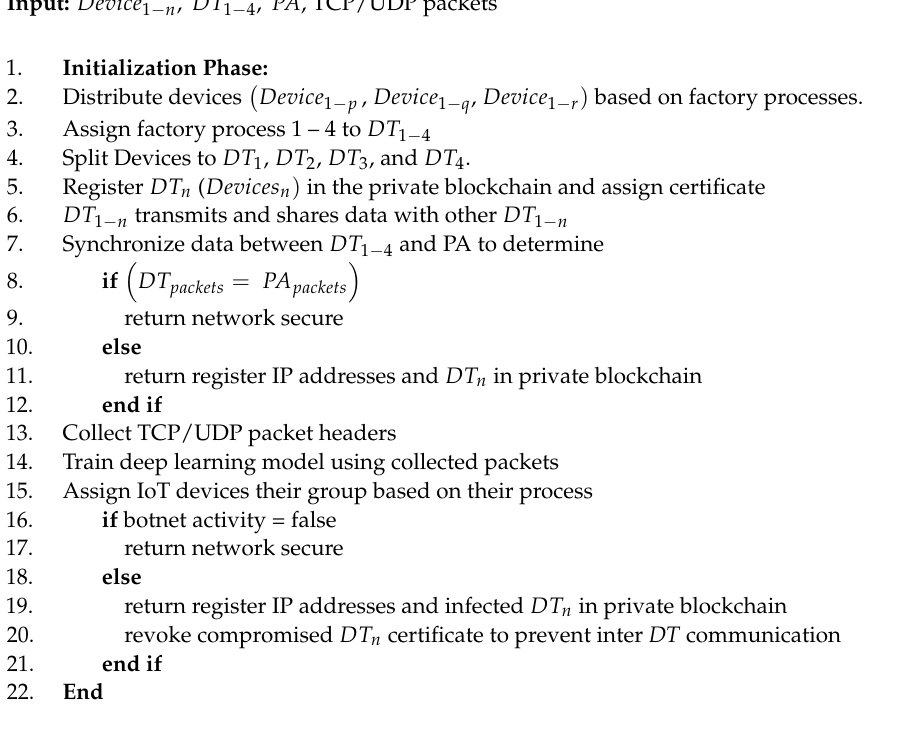
Algorithm 1 The proposed Blockchain-enabled Secure Digital Twin